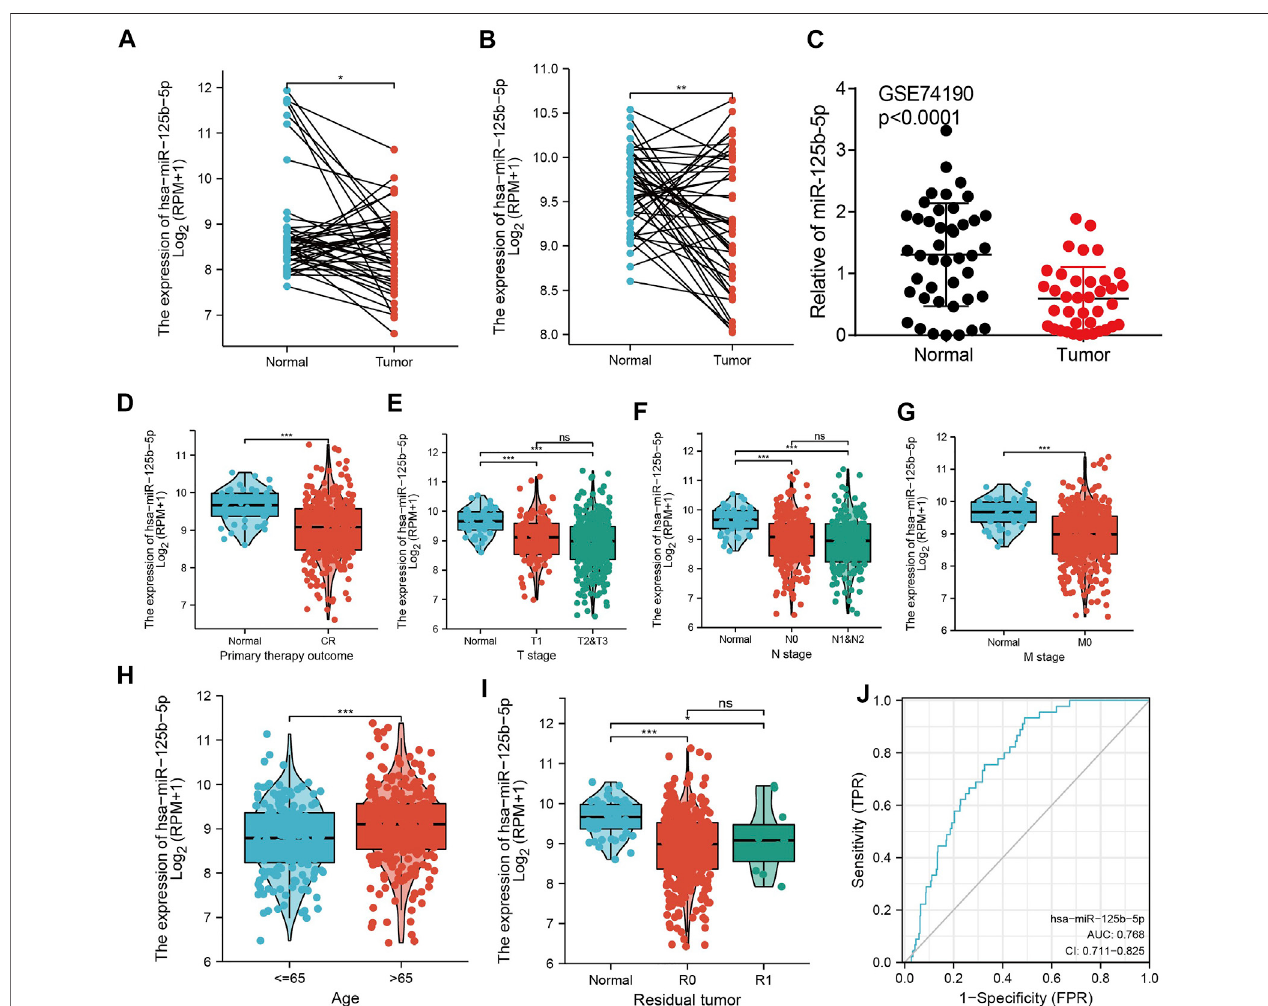
FIGURE 4 | miR-125b-5p wasdecreased in lung adenocarcinoma (LUAD). (A – C) Examination ofthe expression of miR-125b-5p in LUAD in The Cancer Genome Atlas (TCGA) and Gene Expression Omnibus (GEO) datasets. (D – I) Correlation between miR-125b-5p expression and clinicopathological characteristics of LUAD, including primary therapy outcome, TNM stage, age, and residual tumor. (J) Receiver operating characteristic (ROC) curve analysis and area under the curve (AUC) values for miR-125b-5p in LUAD. * p < 0.05, ** p < 0.01, *** p <